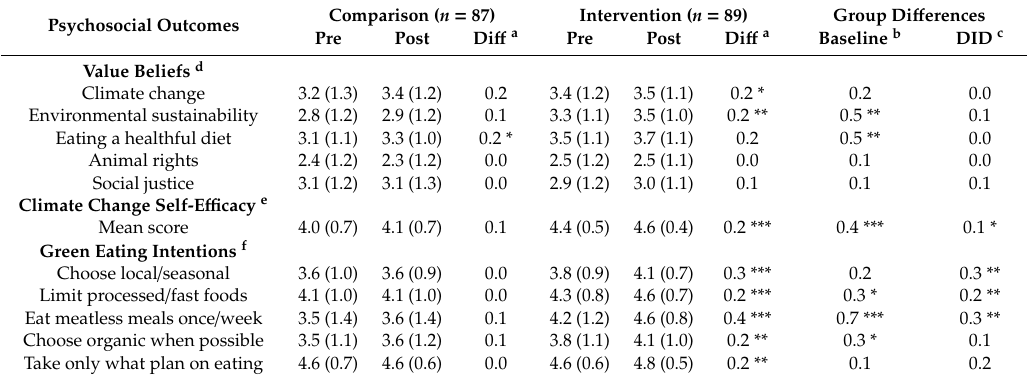
Table 5. Mean (SD) psychosocial outcomes by group and di ff erences between groups.